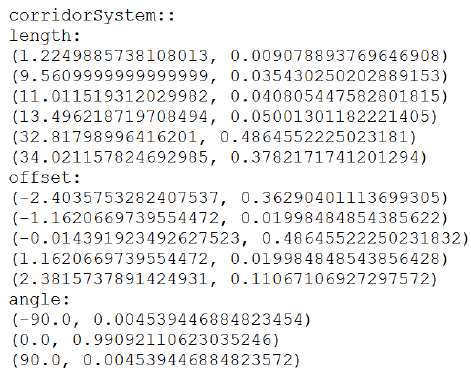
Figure 6. Parameters and probabilities for the CorridorSystem of the data set shown in figure 1